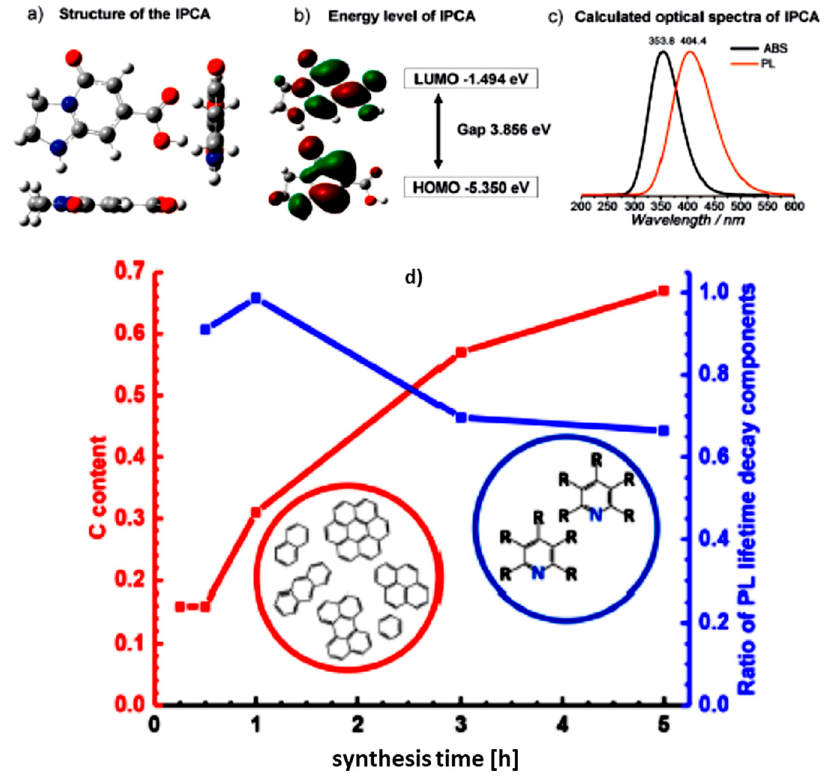
Figure 7. ( a – c ) Calculated structure and optical properties of IPCA molecule (reproduced from [75] with permission of Royal Society of Chemistry, copyright 2015); ( d ) Contribution to PL and structure of CDs vs. synthesis time (reproduced from [47] with permission of American Chemical Society, copyright 2017).